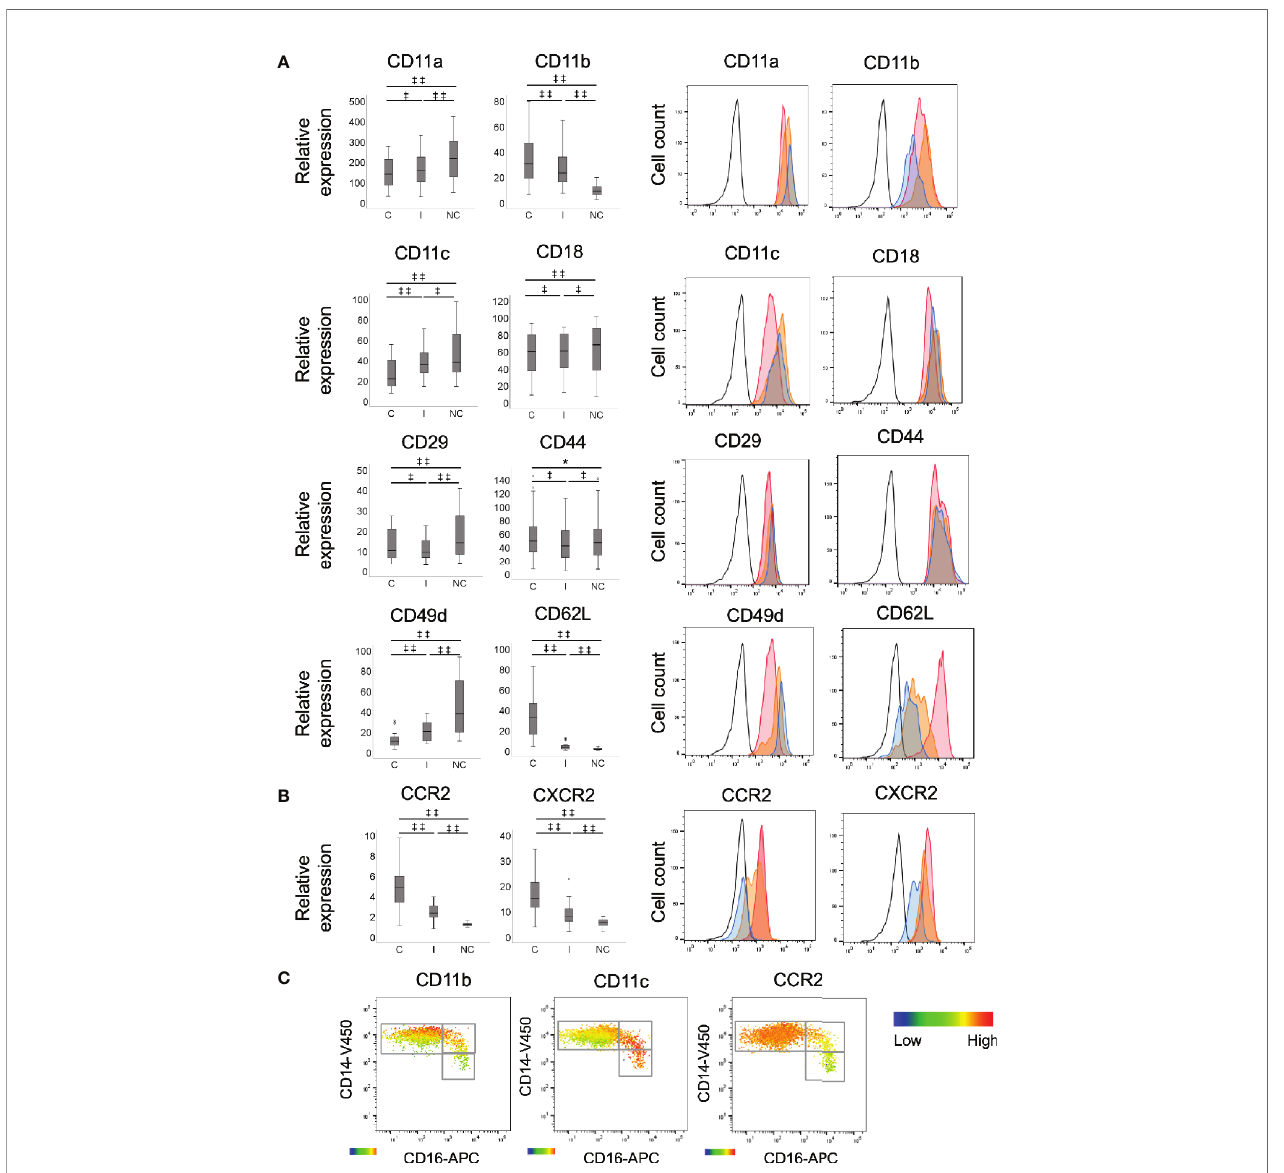
FIGURE 1 | Comparison of recruitment marker expression between monocyte subsets. Expression of (A) adhesion molecules, CD11a, CD11b, CD11c, CD18, CD29 (all integrins), CD44 (selectin), CD49d (integrin) and CD62L (selectin) and (B) chemokine receptors, CCR2 and CXCR2 by monocyte subsets, measured by fl ow cytometry. C: classical; I: intermediate; and NC: non-classical, n=30. Data presented as box and whisker plots, with outliers denoted by circles and representative histograms. Black lined histograms: isotype control, red histograms: classical monocytes, orange histograms: intermediate monocytes and blue histograms: non-classical monocytes. The data were log transformed to appropriate normality and in order to stabilise the variance prior to analysis. Statistical calculations of signi fi cance were performed using repeated measures ANOVA for signi fi cant differences in the relative expression levels of the markers between any 2 monocyte subsets within subject, ‡‡ p < 0.001; ‡ p < 0.01; *p < 0.05 . The differences between subsets were back transformed to provide fold changes (relative to the isotype control) and associated 95% con fi dence intervals (CIs). (C) Differential expression of recruitment markers on monocyte subsets. Heat map showing the degree of expression from high (red) to low (blue) of integrins, CD11b and CD11c and chemokine receptor, CCR2 on whole blood monocyte population based on CD16 and CD14 expression. The heat maps represent classical, intermediate and non-classical monocytes, respectively. The heat maps were created using Flow Jo